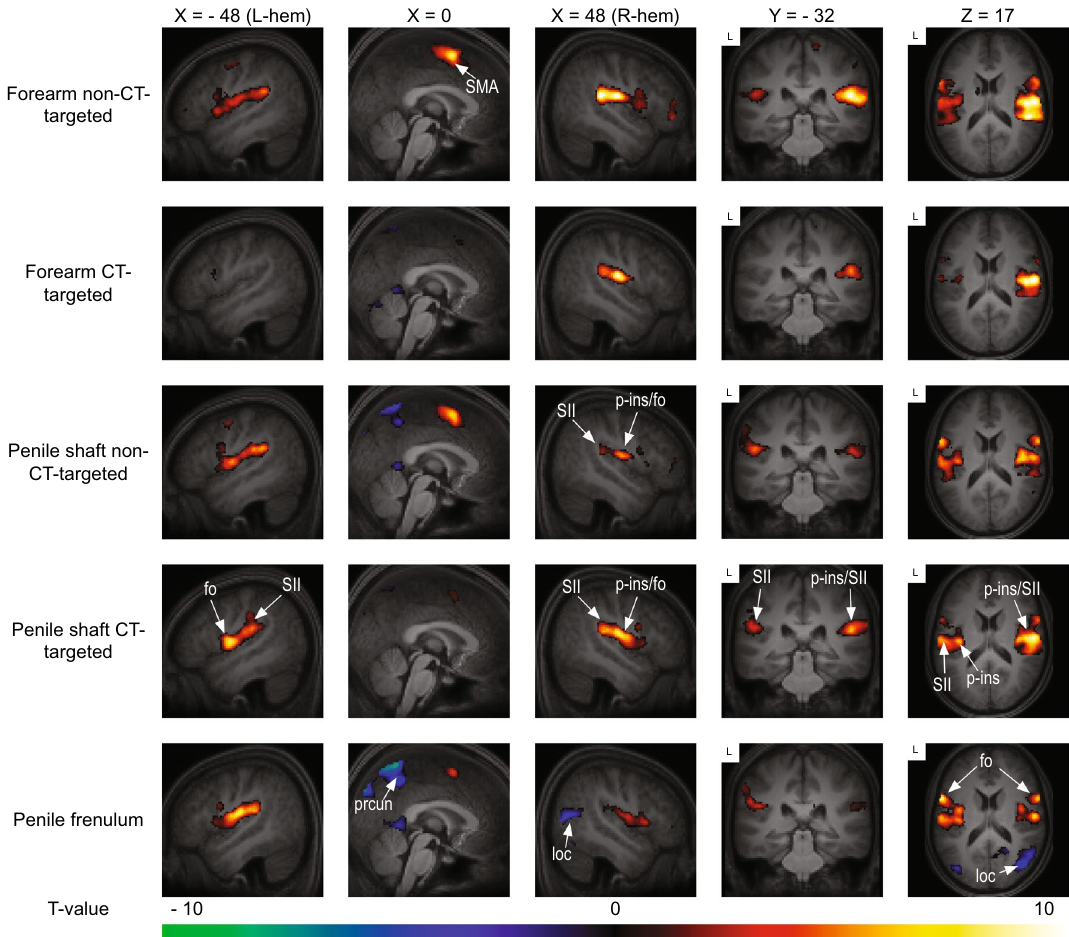
Figure 2. Group level results of the whole-brain analysis of each dynamic touch condition versus baseline (fixation). Red indicates activation relative to baseline, blue indicates deactivation relative to baseline. The template was created by averaging the structural T1-scans of the 19 participants. Results are presented at a threshold of p < 0.05 FWE-corrected. Abbreviations: frontal operculum (fo), lateral occipital cortex (loc), posterior insula (p-ins), precuneus (prcun), supplementary motor area (SMA), secondary somatosensory cortex (SII). FMRI sections were created using FSLeyes (v. 1.3.3; https:// fsl. fmrib. ox. ac. uk/ fsl/ fslwi ki/ FSLey es). Final figure was created using Adobe InDesign 2022 for Mac (v. 17.2; https:// www. adobe. com/ produ cts/ indes ign.